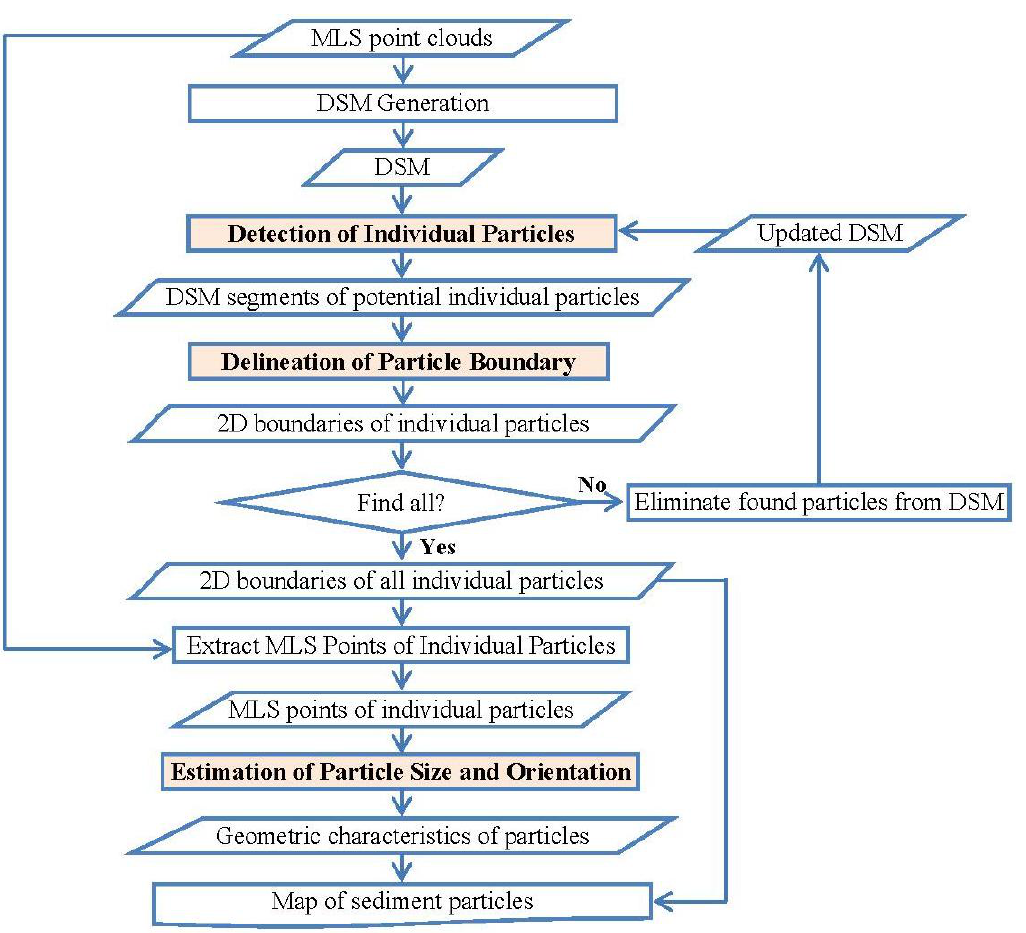
Figure 3. Detailed work flow of the iterative process of the detection, the extraction and the modeling of individual particles. The process iterates through the detection of individual particles and the delineation of the 2D boundary of the detected particles, until no more new particles can be detected from the DSM. The MLS points are then extracted for each particle according to their 2D boundaries. The size, sphericity and orientation of the individual particles are estimated based on the extracted MLS